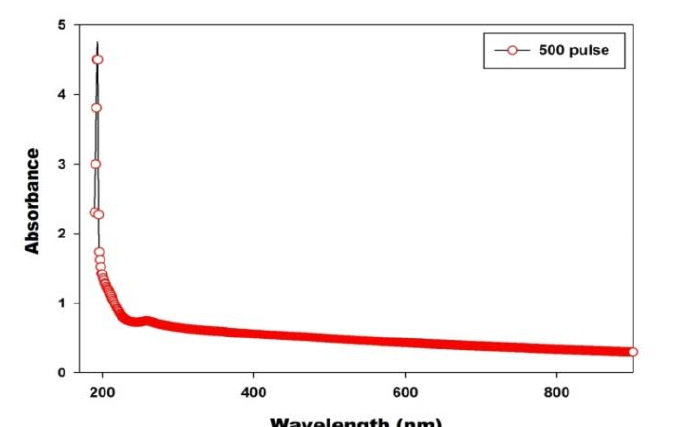
Fig.1: The absorbance of a laser pulse (500 pulses) (Energy (100